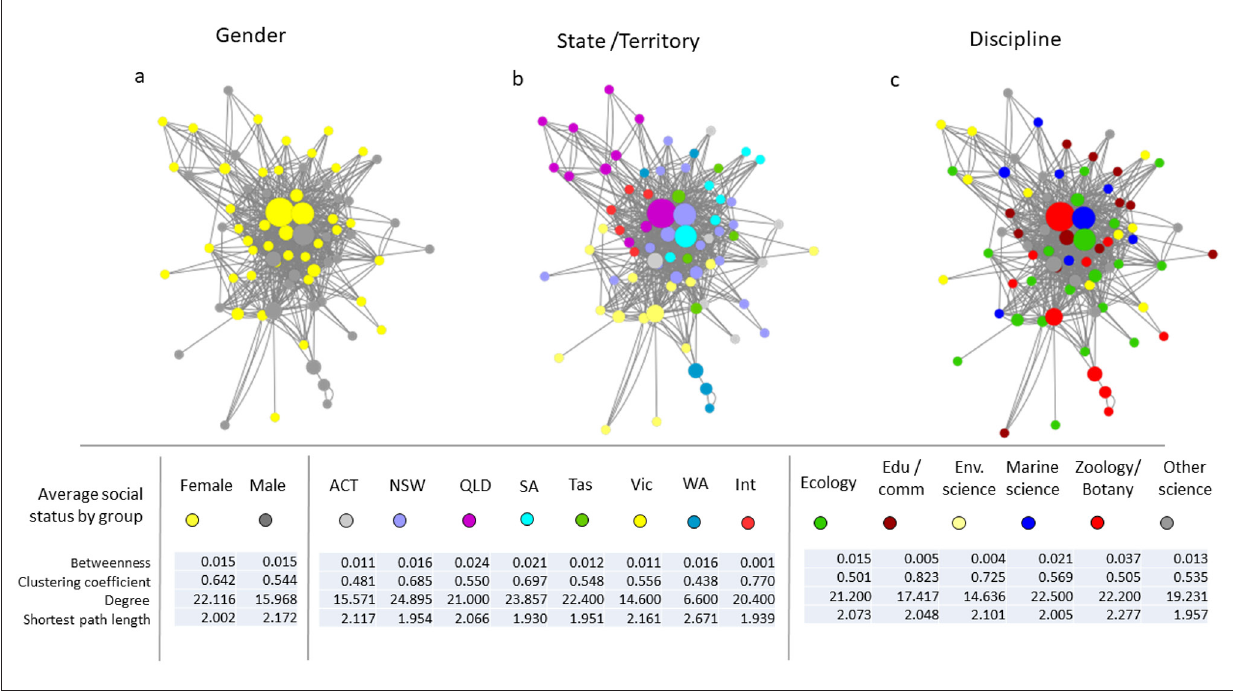
Figure 4 The social status indicators by gender, state/territory, and discipline for the citizen science practitioners network. The size of the nodes reflects the betweenness centrality, that is, indicating a role as a bridge to other parts of the network. Full datasets can be found in Supplemental Tables 6, 8, and 11, Appendix 4: Survey Results. State names have been shortened: ACT: Australian Capital Territory,